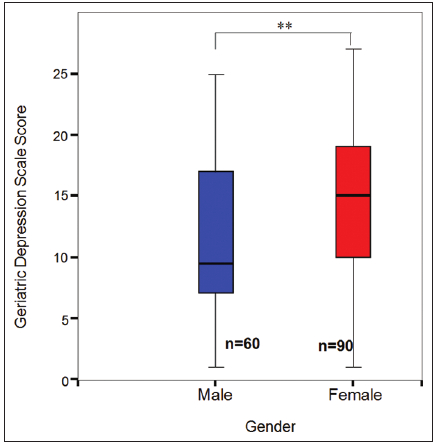
FIGURE 1. Geriatric depression scale score in male and female subjects. **